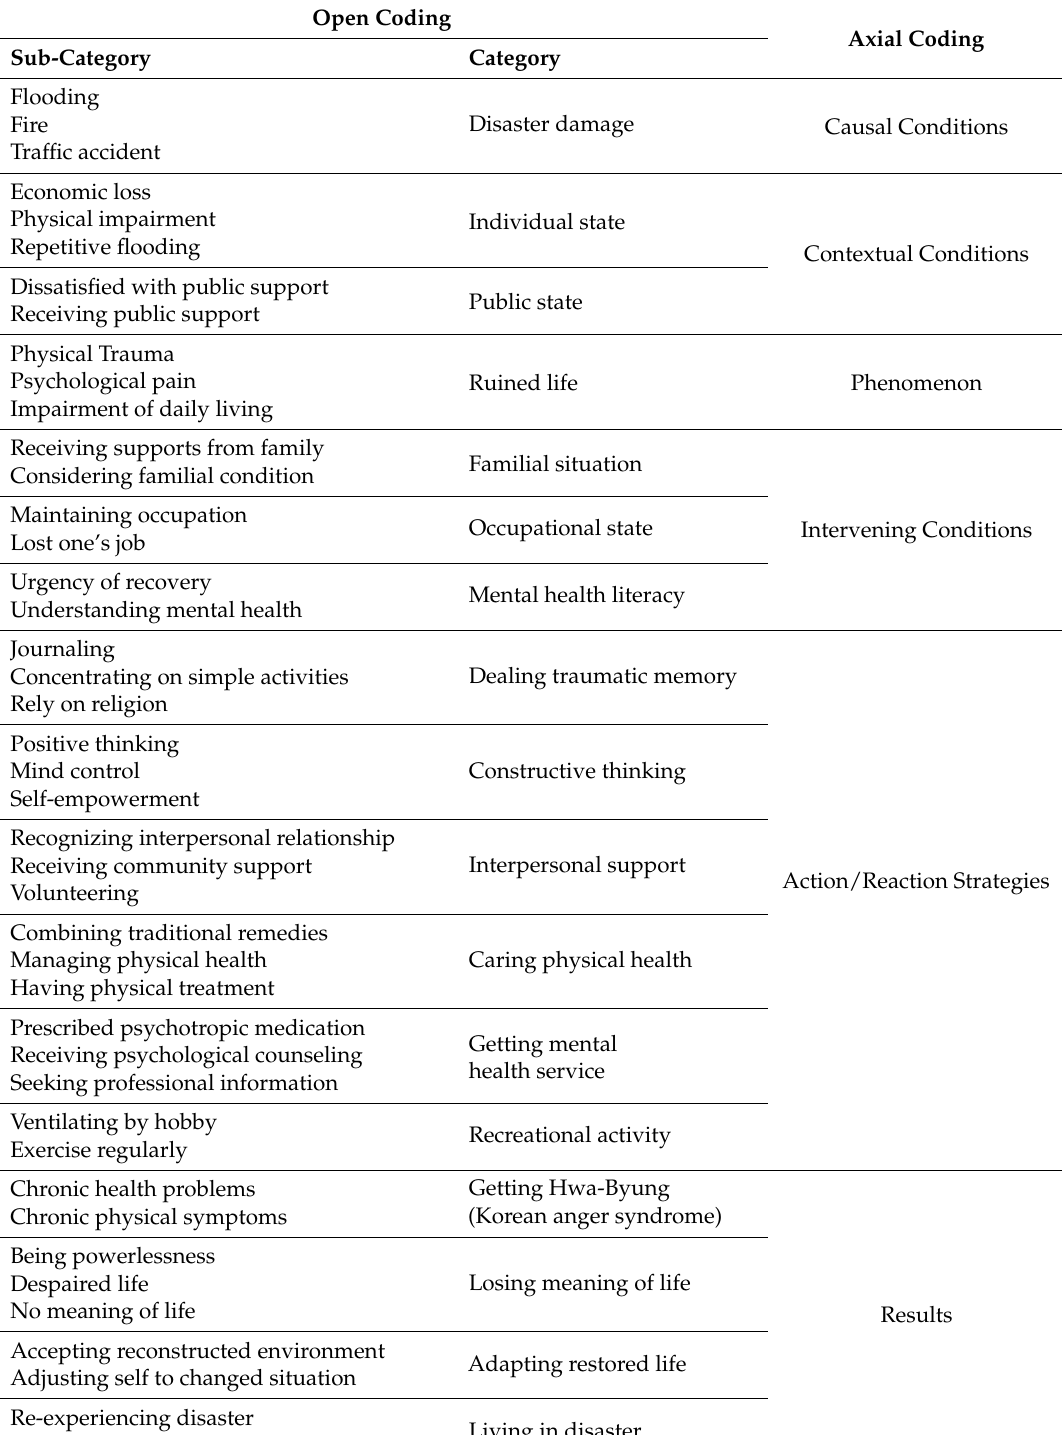
Table 2. Results of open coding and axial coding from the disaster survivors’